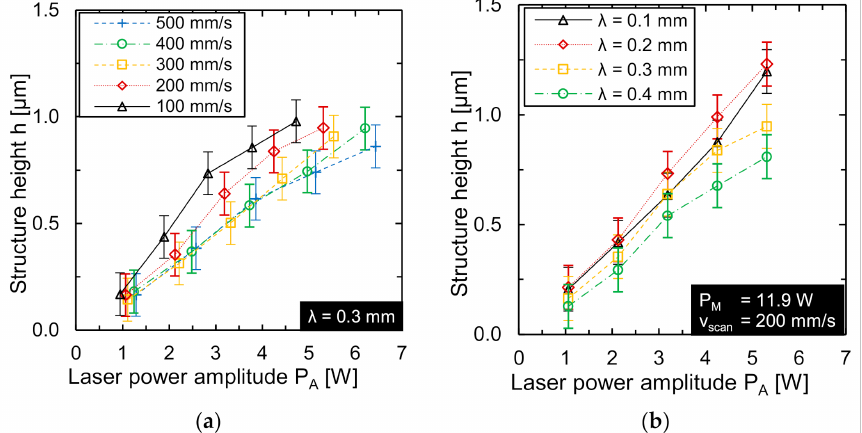
Figure 5. ( a ) Structure height h as function of laser power amplitude P A for different scan speeds ( d L = 50 µ m, λ = 0.3 mm, P M and P A adapted to v scan ), and ( b ) structure height as function of laser power amplitude for different wavelengths ( d L = 50 µ m, P M = 12.2 W, v scan = 200 mm/s).